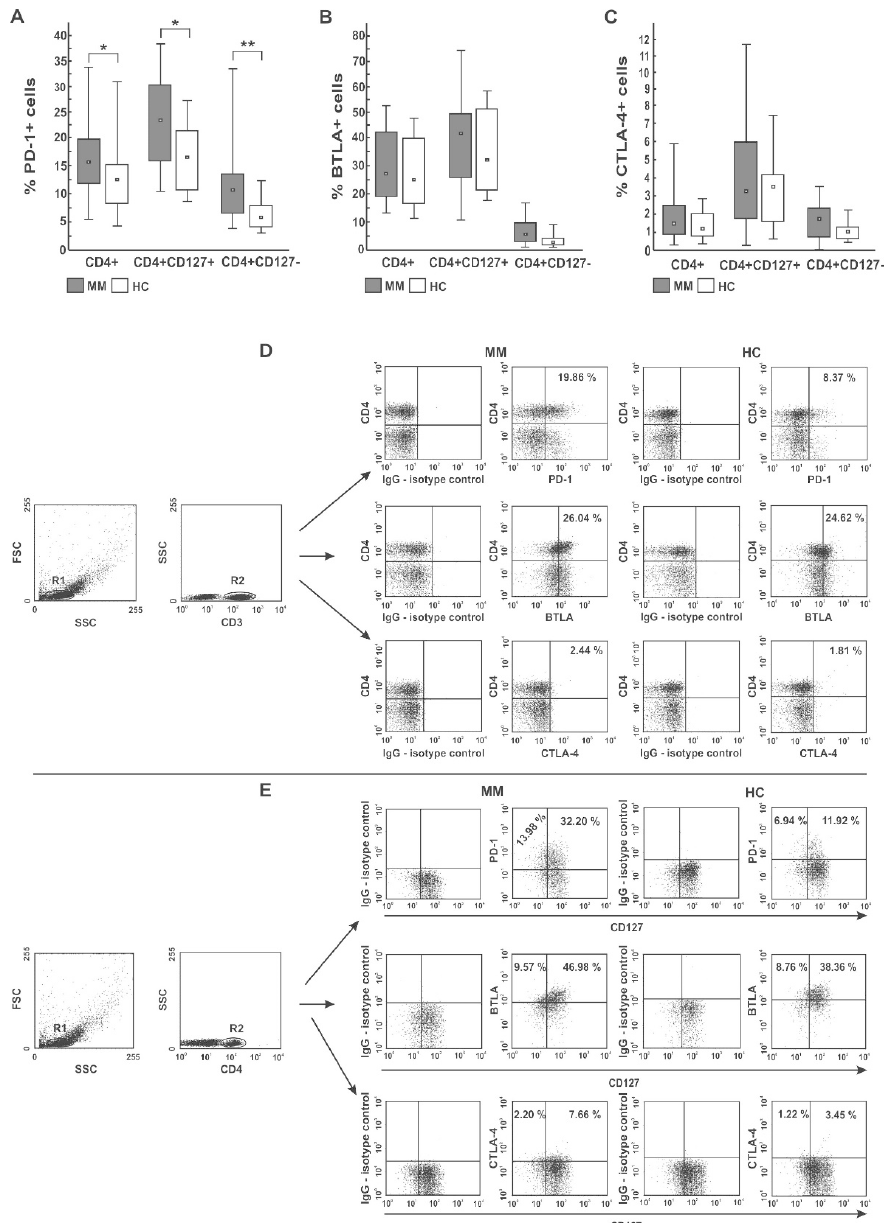
Figure 1. Distribution of PD-1 ( A ), BTLA ( B ), and CTLA-4 ( C ) immune checkpoints in different PB CD4 T-cell subsets. Among studied inhibitors, significant differences between myeloma patients (MM) and healthy controls (HC) were found in PD-1 expression only ( p < 0.05). The frequency of BTLA + and CTLA-4 + cells did not significantly differ between MM and HC ( p > 0.05). Boxes and whiskers 25th–75th interquartile range and minimum-maximum, respectively; the median is the central square in each box. ** represents p < 0.01 and * represents p < 0.05. ( D , E ) Representative dot plots show PD-1, BTLA, and CTLA-4 expression in PB CD4 T cells. Numbers on dot plots represent the frequency of PD-1 + , BTLA + , or CTLA-4 + cells within the examined subsets. The percentages of cells expressing the immune checkpoint receptors were determined using isotype control IgG. The statistical analysis was performed using the Mann-Whitney U-test.